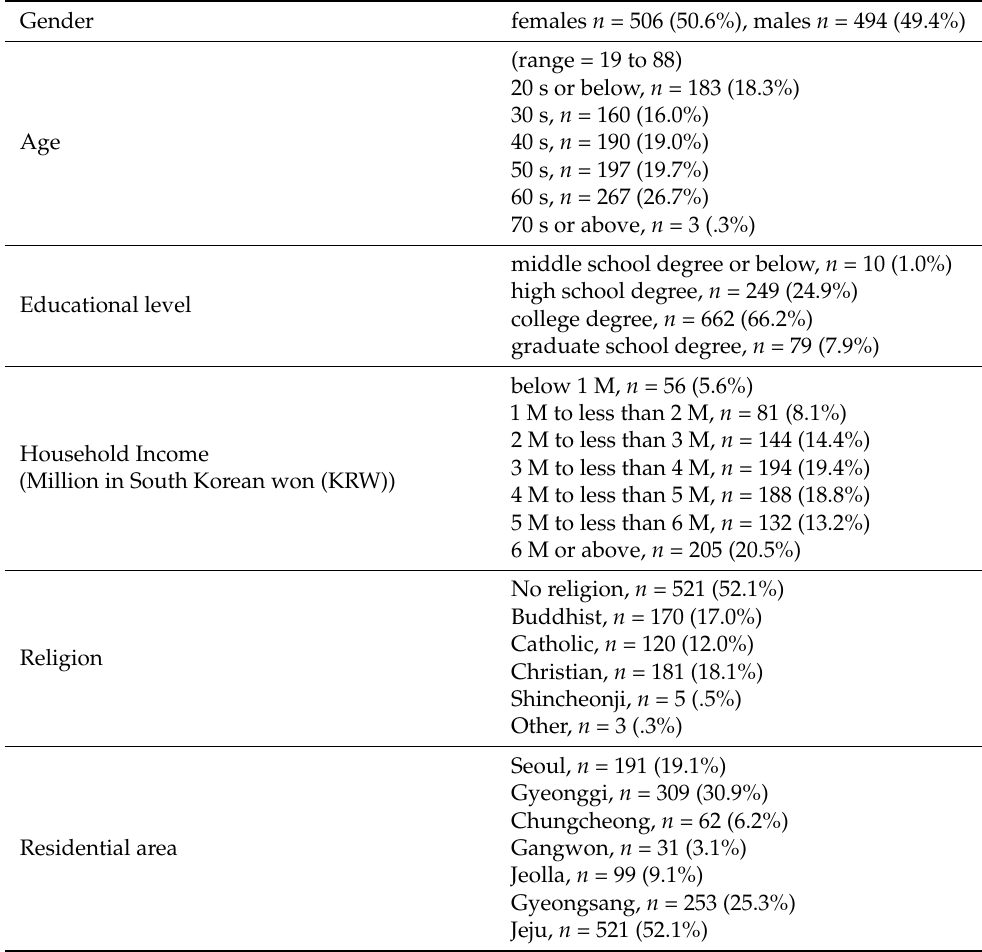
Table 1. Demographic Characteristics ( n =